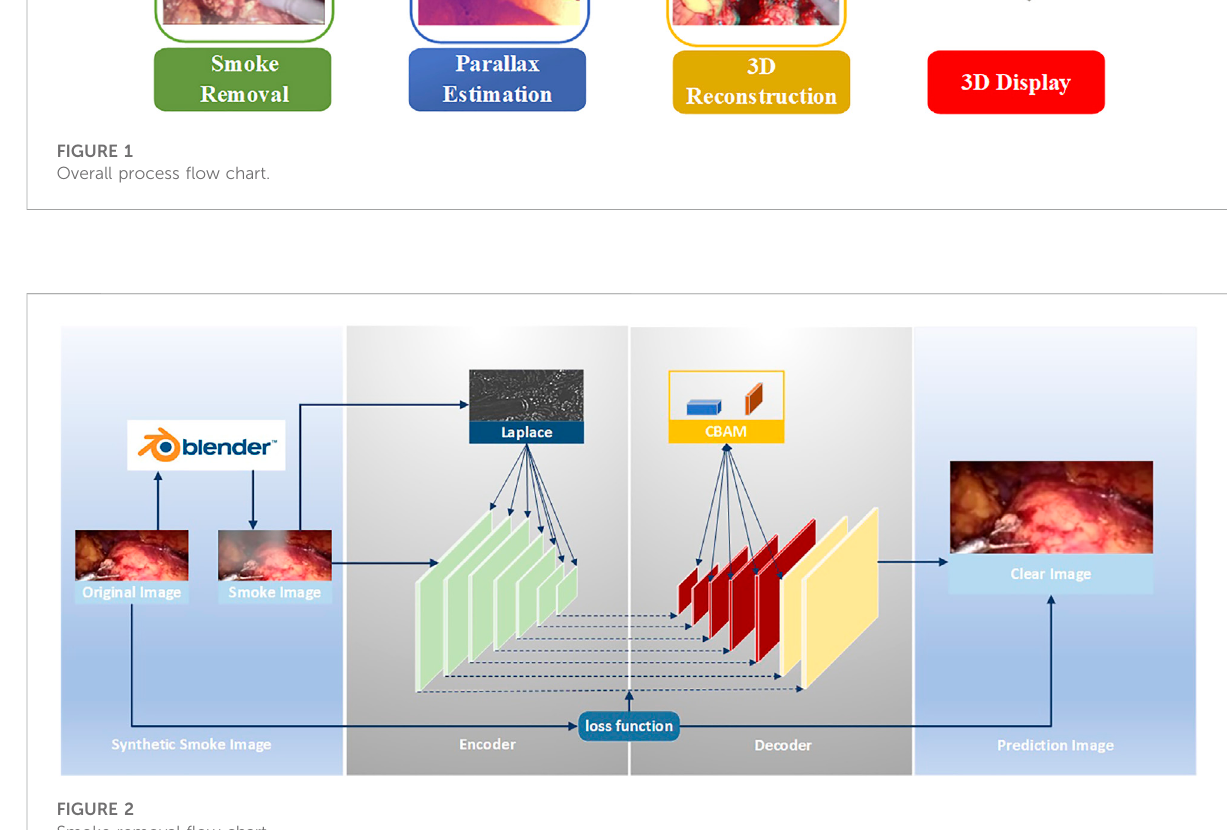
FIGURE 2 Smoke removal fl ow